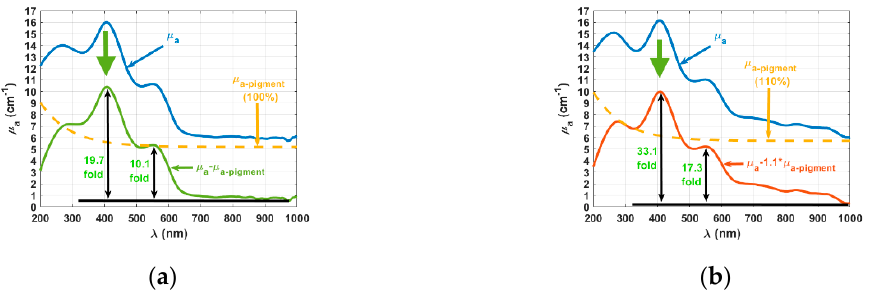
Figure 13. Wavelength dependencies of µ a for the pigment, for normal ( a ) and for pathological ( b ) mucosa, before and after subtracting the absorption of the pigment.